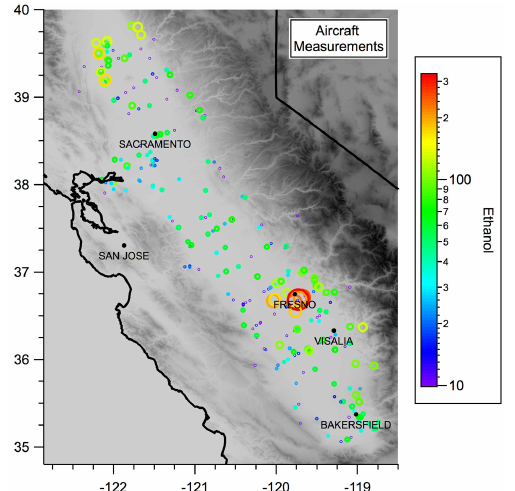
Figure 14. Map of observed methane concentrations over 7 flights in California’s Central Valley shown as individual circles, sized and colored by methane concentration. Data were taken at varying al- titudes above and below the boundary layer with general filter for below 1000m. Vertical gradients and multiple flights are responsi- ble for some variability, but methane enhancements in aircraft data show good correlation with the location of dairy operations (open black circles sized by bovine population). A map including the en- tire Sacramento Valley can be found in the Supplement (Fig.